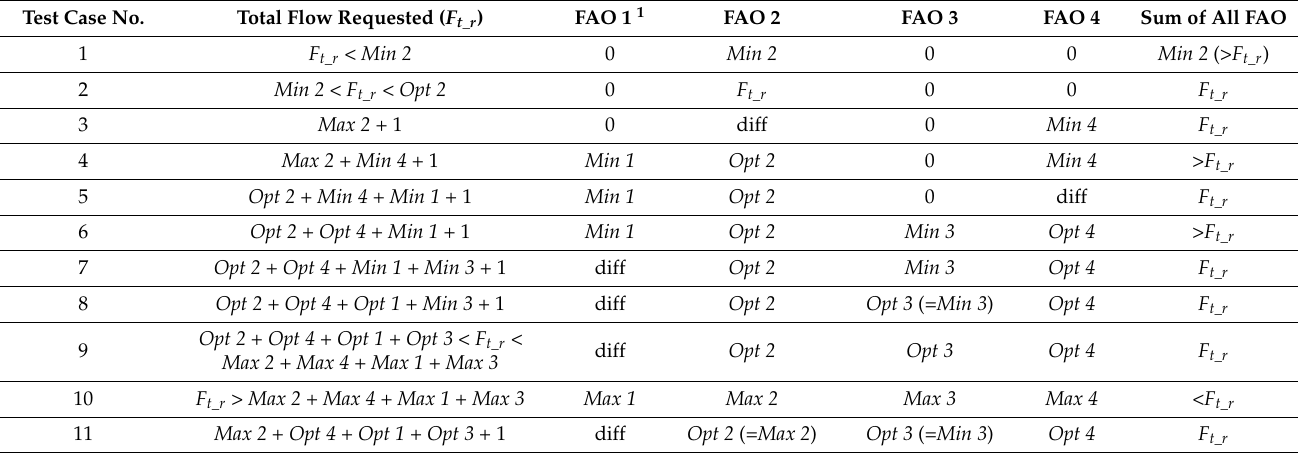
Table 6. The test cases executed and their results, in the second test